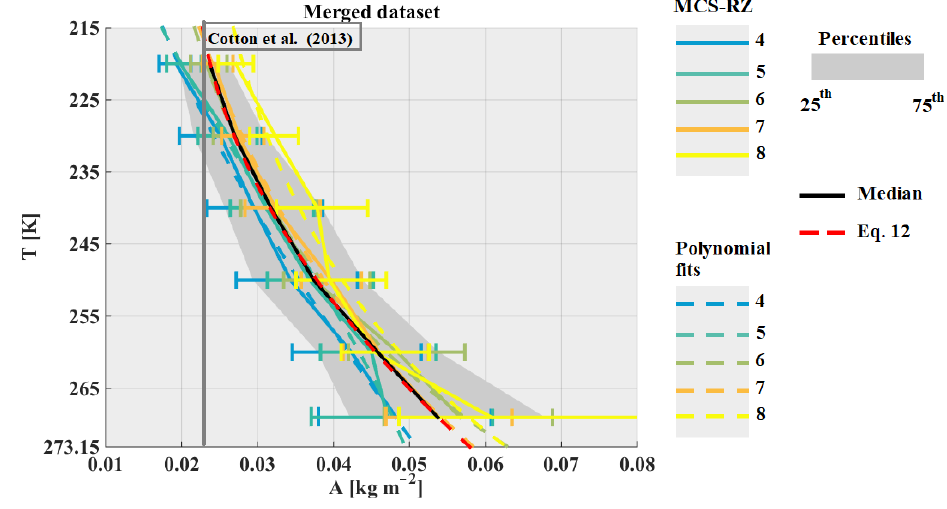
Figure 25. The same as Fig. 5 but for the ratio A = IWC /M 2 in [kgm − 2 ].